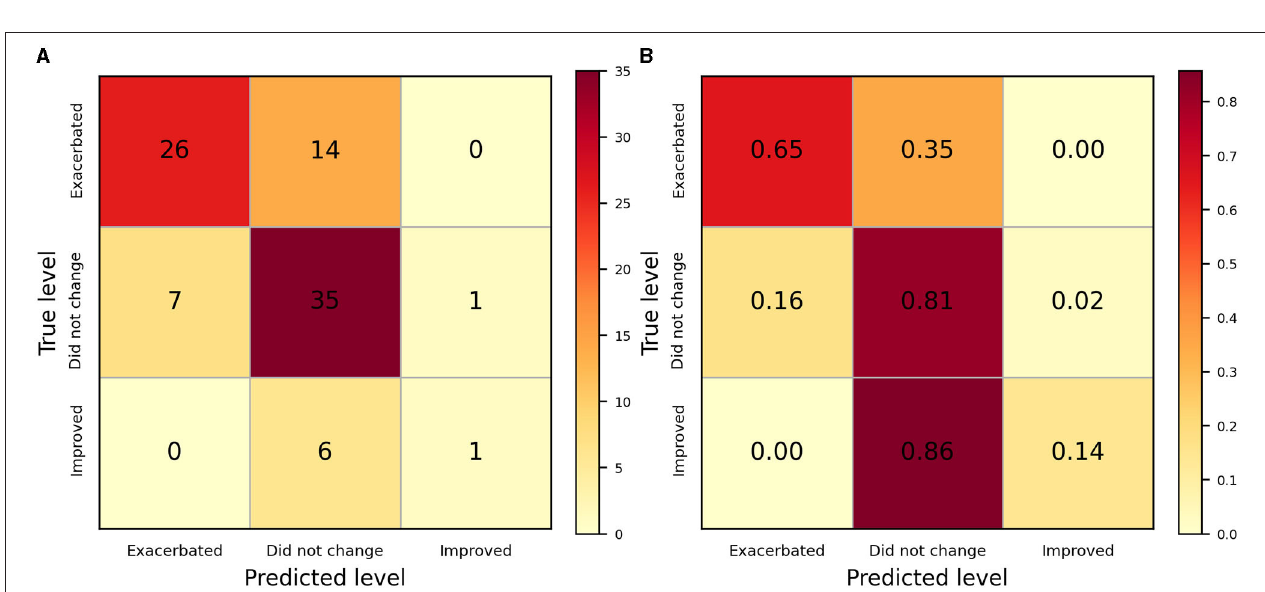
FIGURE 3 | The confusion matrix of SSA-PNN. (A) The confusion matrix. (B) The normalized confusion matrix. The plots revealed the performance of identifying various levels of LBP, Among them, “did not change” had a better result.